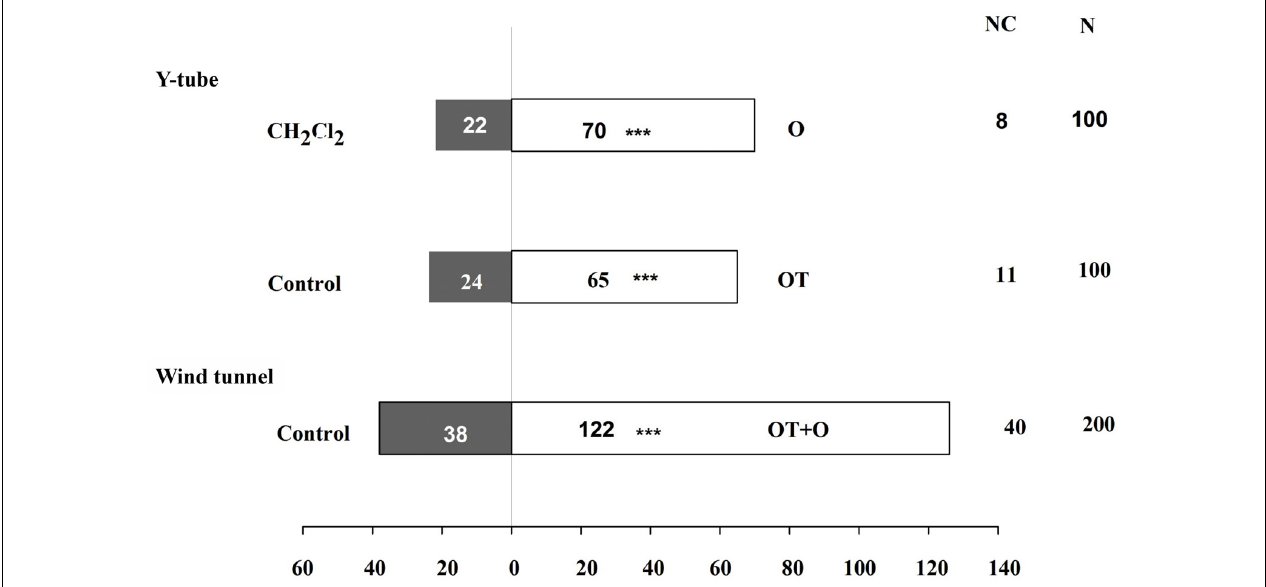
FIGURE 4 | Flight behavior of aphid endoparasitoid, Aphidius gifuensis on β -ocimene-treated and control Chinese cabbages. O, purified β -ocimene; OT, β -ocimene treated Chinese cabbage; OT+O, β -ocimene treated Chinese cabbage with purified β -ocimene. Different letters over the bars designate a significant difference: ∗ P < 0.05, ∗∗ P < 0.01, ∗∗∗ P <